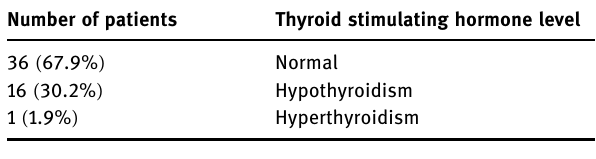
Table 4: Thyroid dysfunction and plasmapheresis e ff